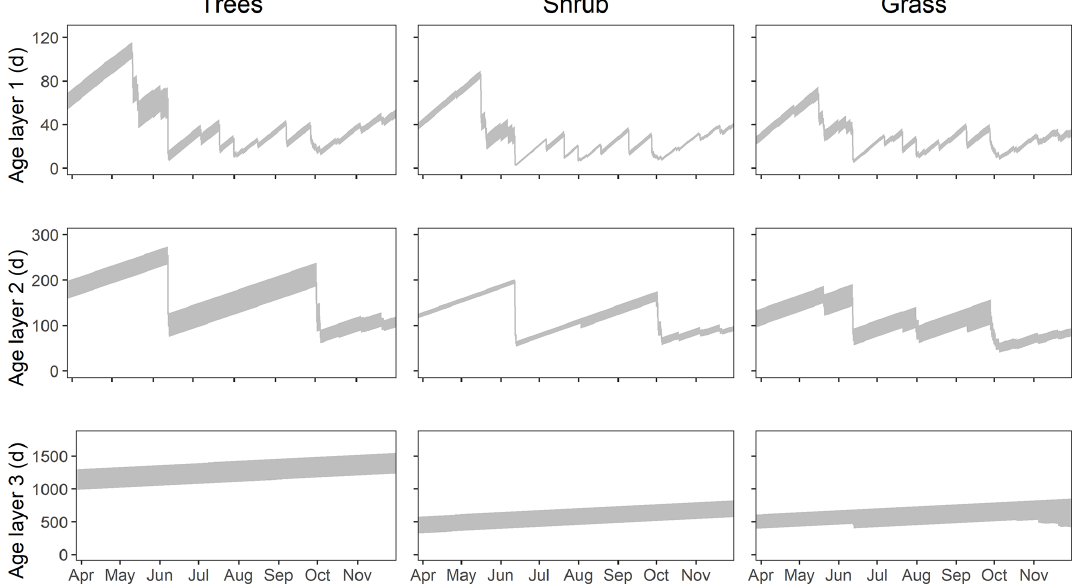
Figure 9. Simulated water ages (days) in soil layers 1, 2 and 3 under trees, shrub and